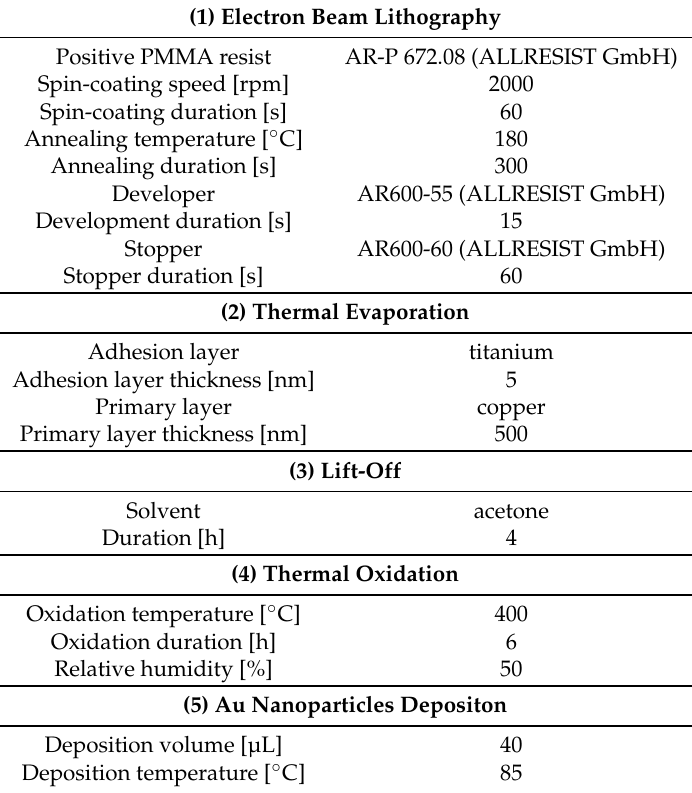
Process parameters for the fabrication of the CuO thin film functionalized with Au